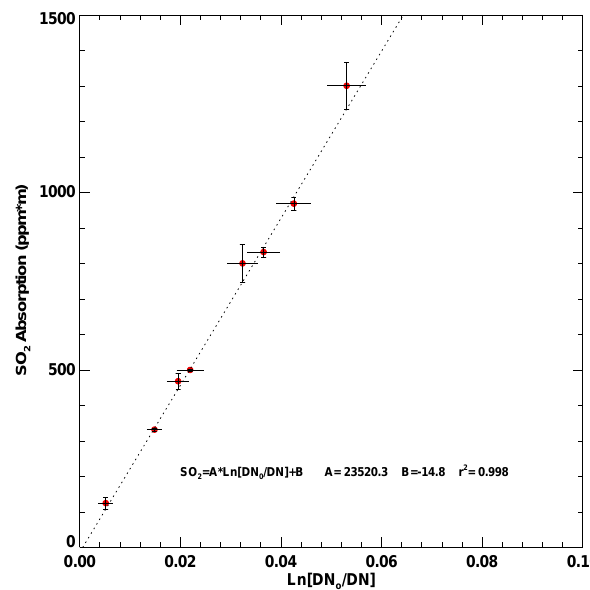
Fig. 5. Calibration curve determined used bright diffuse skylight as FIGURE5. CalibrationcurvedeterminedusedbrightdiffuseskylightasasourceandSO 2 pathamounts (inppm*m)inquartzglasscells.TheSO 2 cellpathamountswereindependentlymeasuredusingaspec- a source and SO 2 path amounts (in ppmm) in quartz glass cells. trometer. The SO 2 cell path amounts were independently measured using a